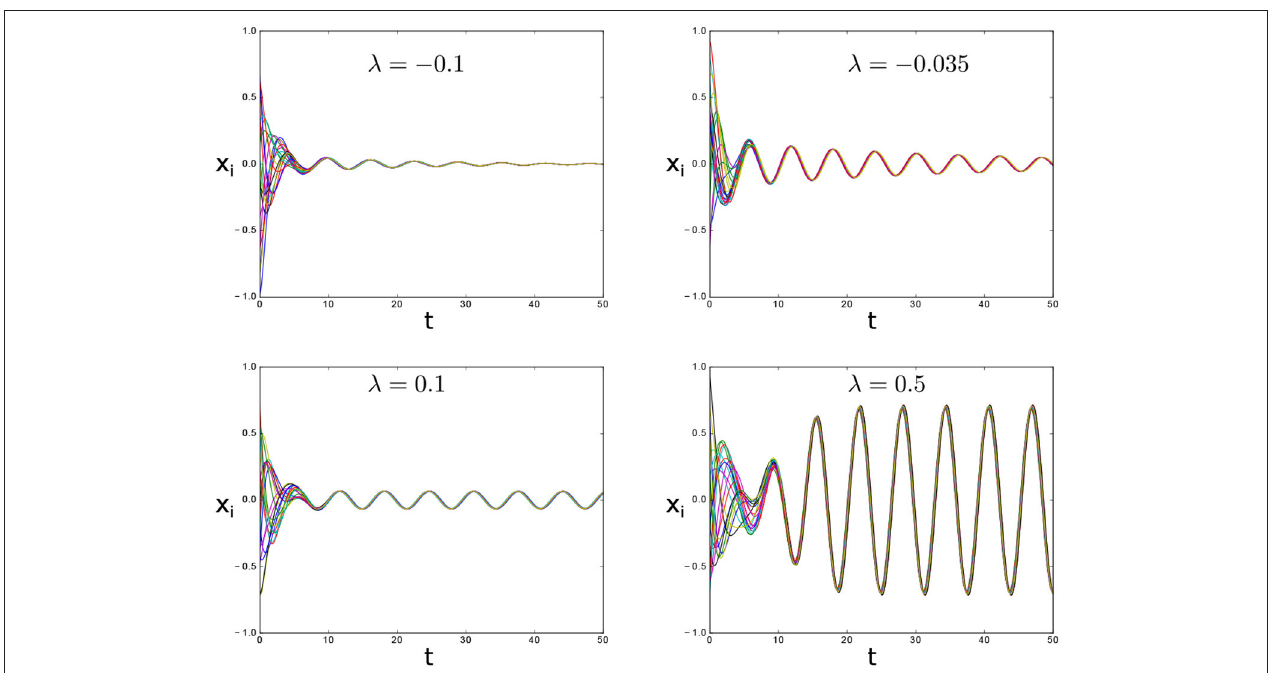
0.05, N 20, natural frequencies = =